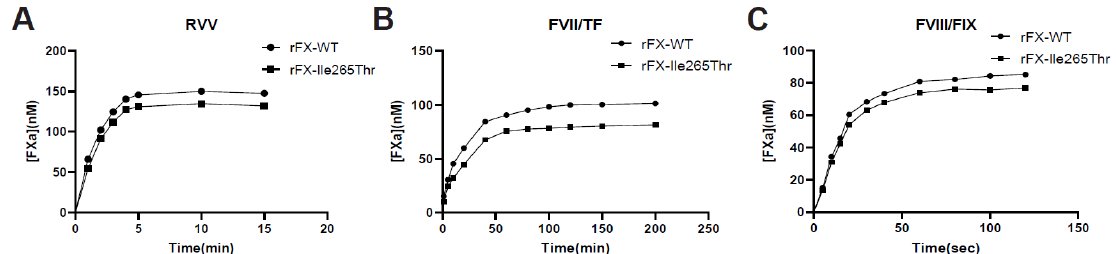
Figure 4. ( A ). Activation of recombinant FX-WT and FX- Ile265Thr by RVV. RVV(100 nM) was used to activate 150 nM FX-WT( ● ) or FX-Ile265Thr ( █ ) at 37 °C. The concentration of FXa was monitored by measuring the rate of chromogenic substrate hydrolysis as described under “Materials and Methods.” ( B ). Activation of recombinant FX-WT and FX- Ile265Thr by extrinsic way. 150 nM FX-WT( ● ) or FX-Ile265Thr ( █ ) were activated by 60 pM FVIIa in the presence of 500 pM lipidated tissue factor. ( C ). Activation of recombinant FX-WT and FX- Ile265Thr by intrinsic way. 150 nM FX-WT( ● ) or FX-Ile265Thr ( █ ) were activated by 5 nM FIXa in the presence of 4 units/mL FVIIIa on 20μM PE:PS:PC vesicles(5:3:2 w / w ). Data are derived from three independent measurements (SD).